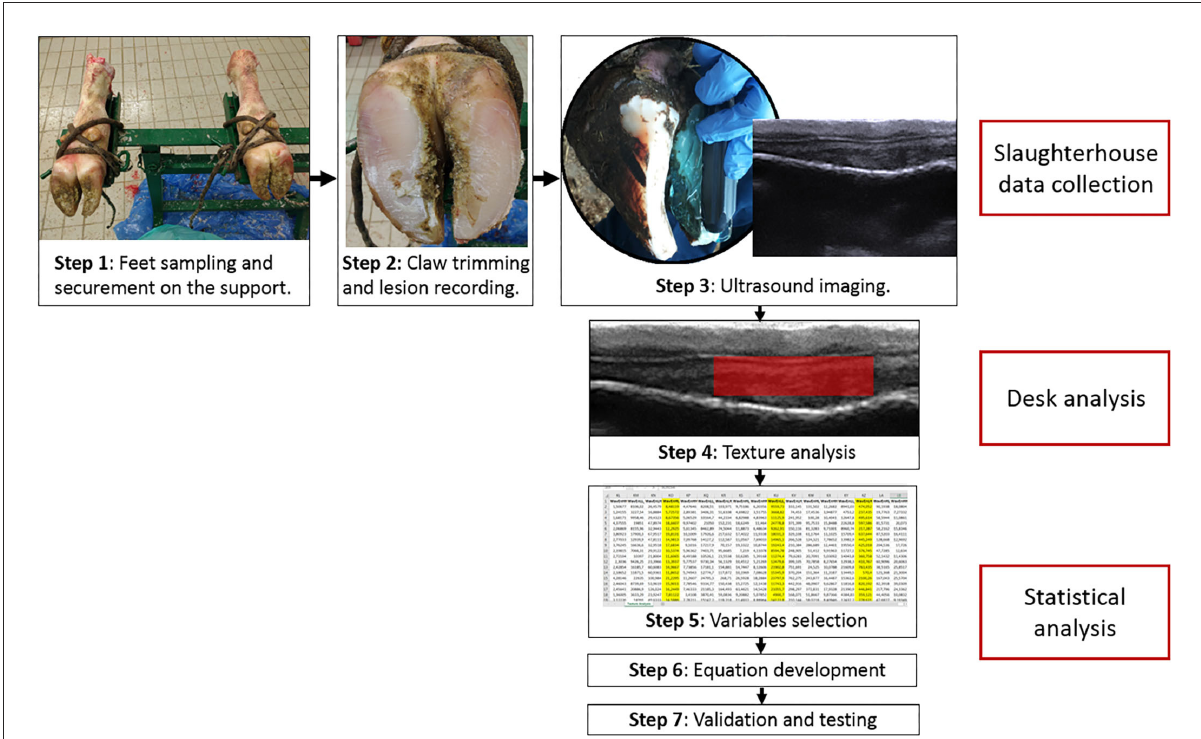
FIGURE1 Operational flow chart of the methods in the study. Steps 1–3 were performed at the slaughterhouse and consisted in: securing the limbs to the support (step 1), claw trimming and lesion recording (step 2), ultrasound imaging (step 3). Step 4 was texture analysis with Mazda program on US images and measurement of S1, S2, and S3 sole soft tissue thickness. Steps 5–7 were performed statistically and consisted in: selection of the variables to include in the equation using stepwise analysis (step 5), development of the equation (step 6), and validation of the equation and performance testing using ROC, precision-recall curve and confusion